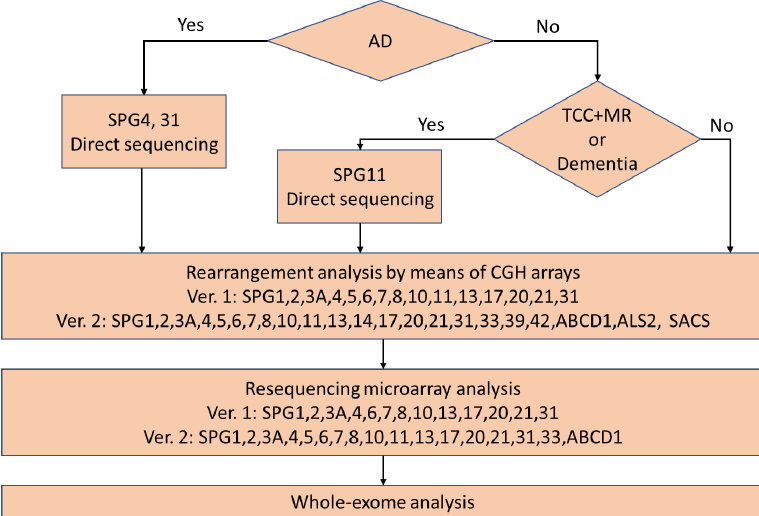
Figure 1. The earlier version of flow chart for our diagnostic procedure. In the current version, whole exome analysis is performed after excluding SPG4 (and SPG3A and SPG31 in patients with early-onset diseases) in familial patients with pure form. AD: autosomal dominant inheritance, TCC: thin corpus callosum, and MR: mental retardation.